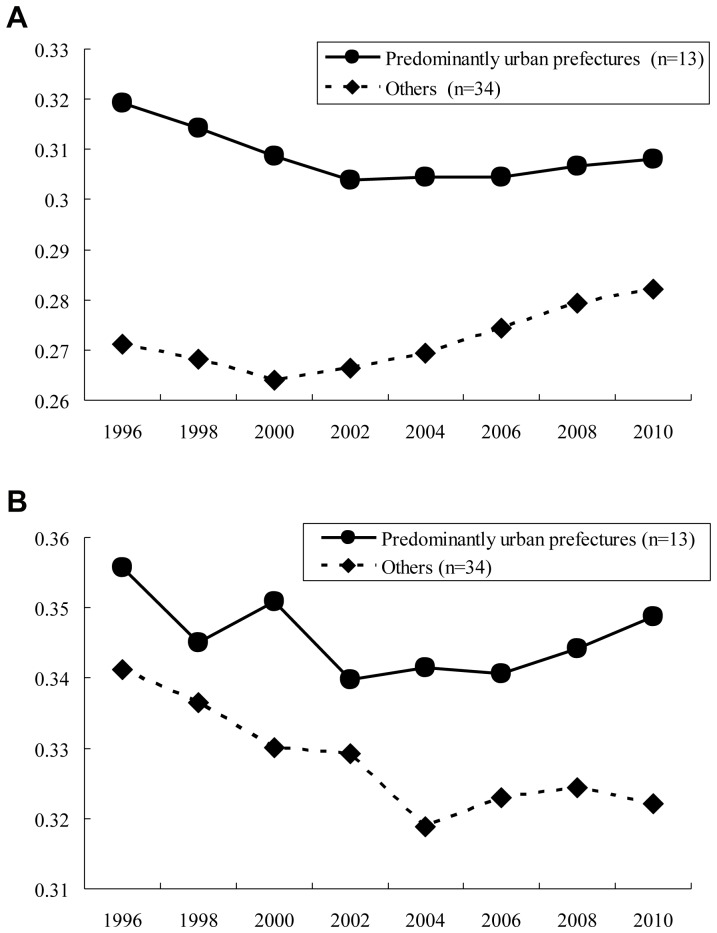

Figure 2-a Mean Gini coefficients of all physicians in intra-prefectural distributions; Prefectures were classified into predominantly urban prefectures and others according to the definition of OECD.
Figure 2-b Mean Gini coefficients of pediatricians in intra-prefectural distributions; Prefectures were classified into predominantly urban prefectures and others according to the definition of OECD.